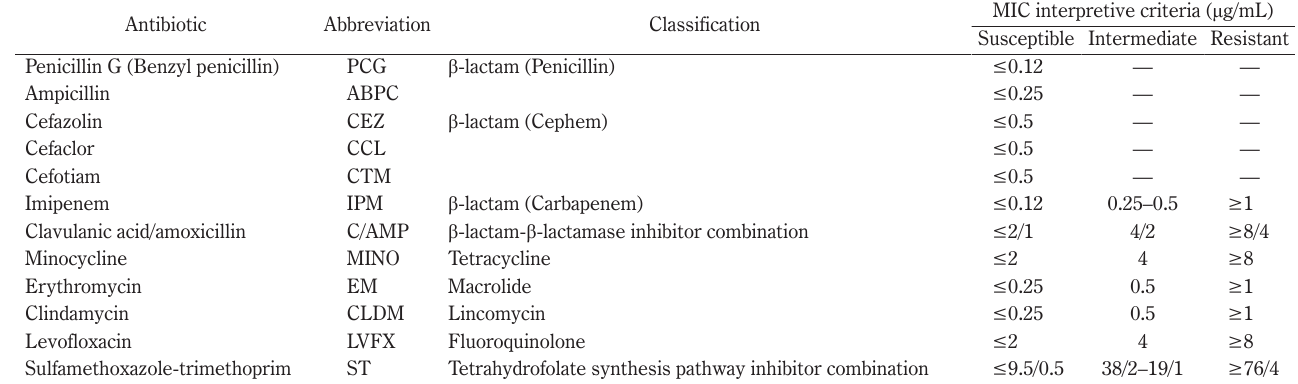
Table 1 Antibiotics used in antimicrobial susceptibility